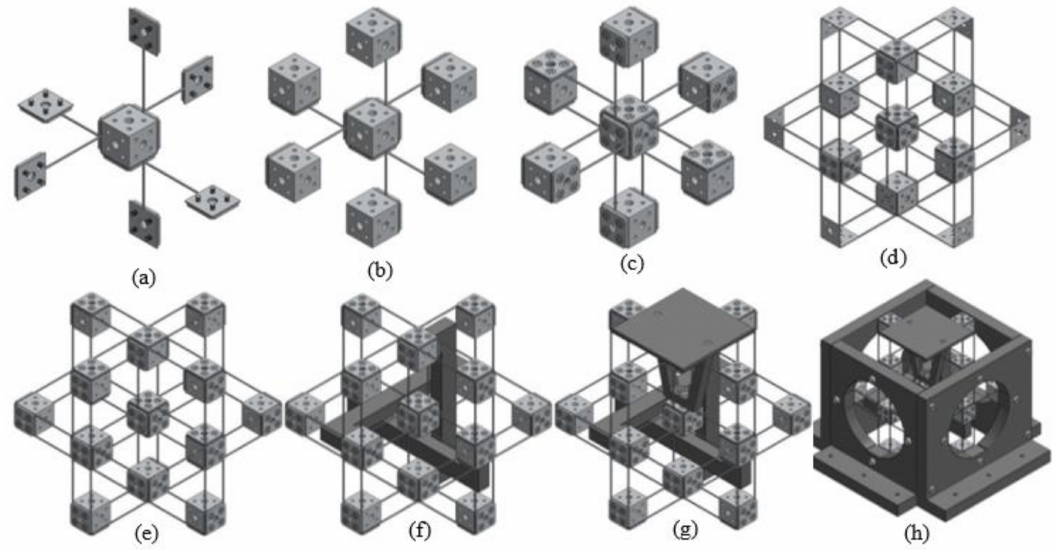
Figure 14. Assembling demonstration of the practical design: ( a – e ) assembling of rigid cubes, rigid washers, compliant PM beams, and compliant AM beams; ( f ) assembling of three RLs; ( g ) assembling of output platform; and ( h ) assembling of supporting